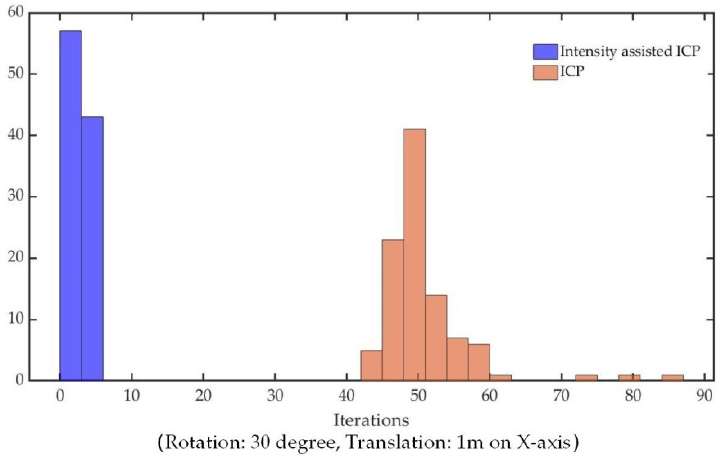
Figure 8. The number of iterations required for intensity-assisted ICP and conventional ICP to converge.